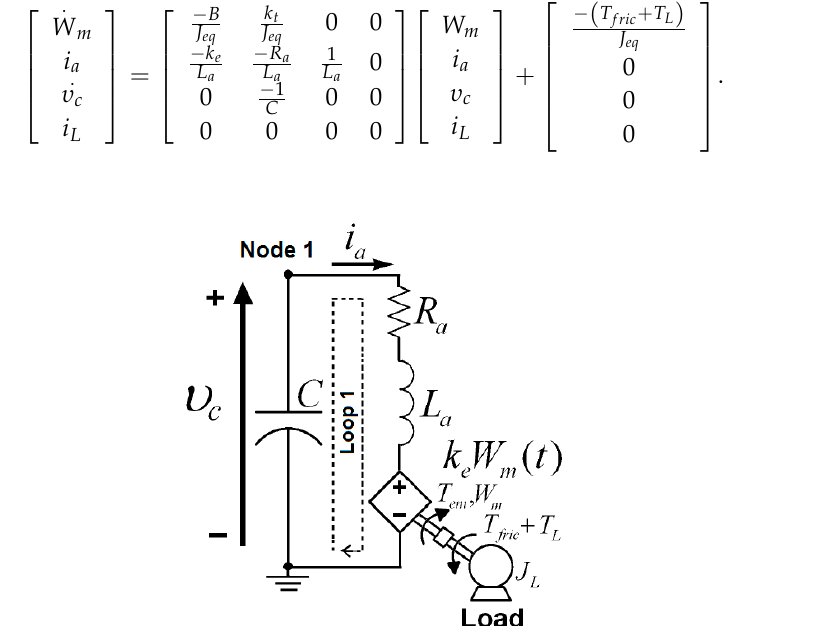
Figure 5. Buck-motor system working in discontinuous conduction mode (DCM).